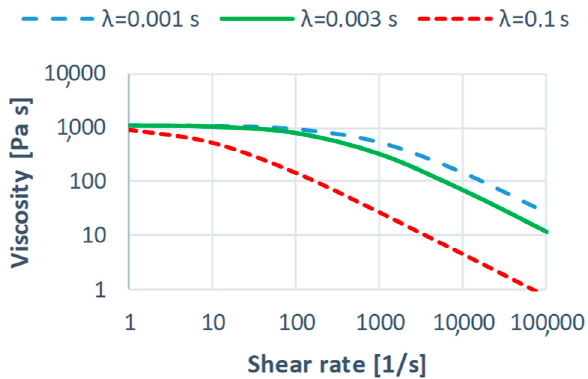
Figure 6. E ff ect of the relaxation time λ = η 0 / τ ∗ on the viscosity curve in relation to PBT Valox 337 ( λ = 0.003 s, calculated for T = 252 ◦ C).